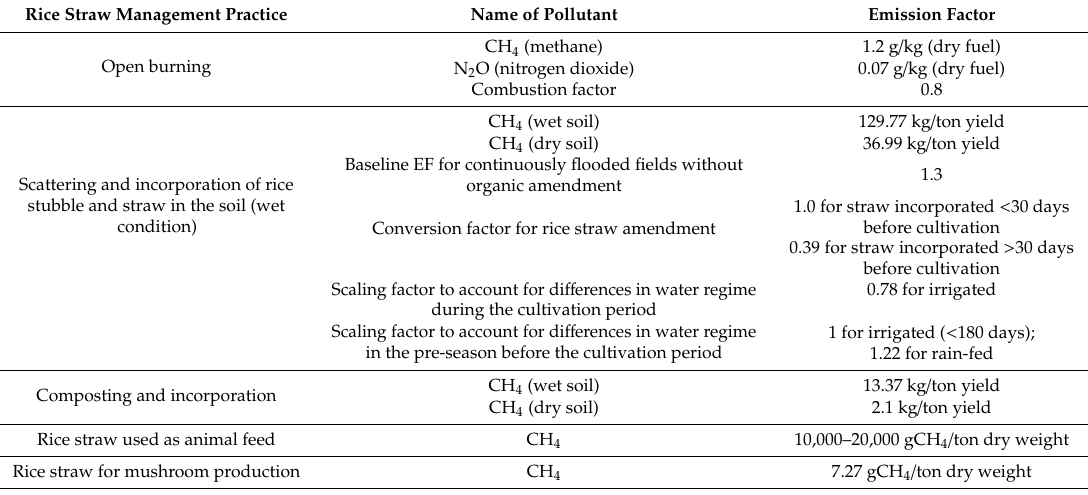
Table 4. GHG emission factor (EF) for di ff erent rice straw management practices